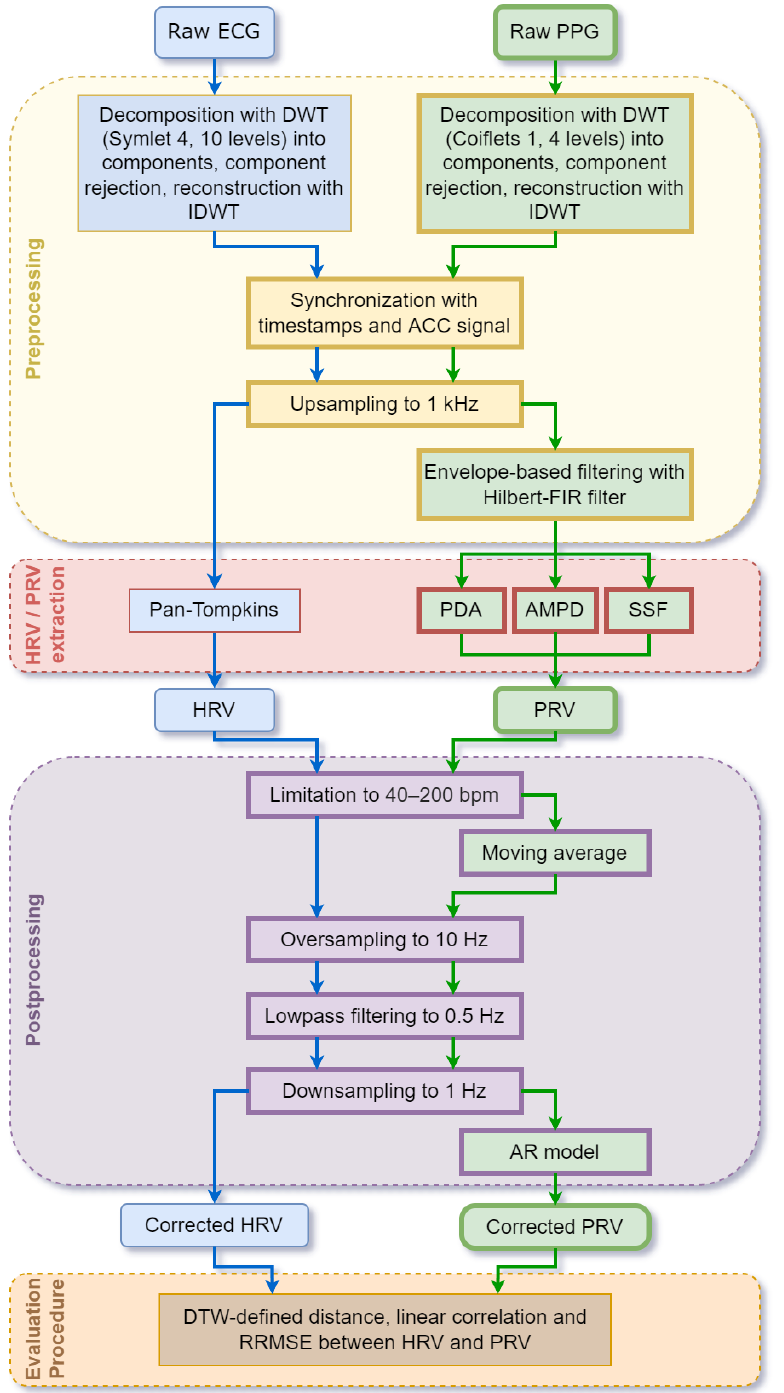
Figure 2. ECG and PPG processing flows. ECG is used as a reference to validate our new PPG processing method (blocks with thicker